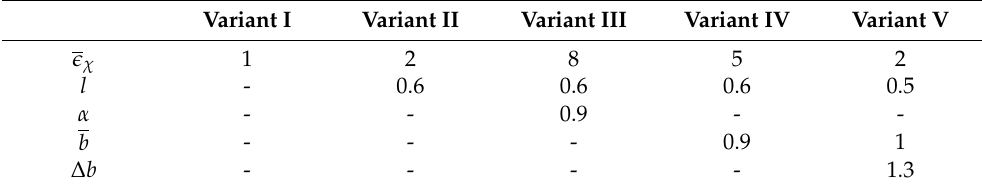
Table 3. Values of parameters used to calculate the optimal weighting factor (cid:101) χ ; indicator q , simulation scenario Cloud 2 .